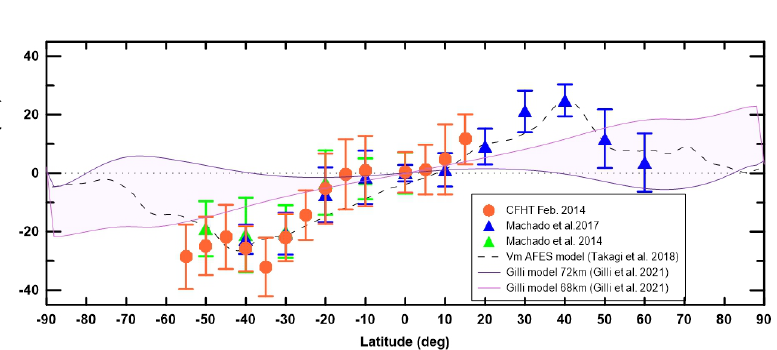
Figure 12. Comparison between a model’s predicted meridional flow latitudinal velocity profile and the profiles retrieved from ground-based observations and Doppler velocimetry techniques applied to the high-resolution spectra obtained with ESPaDONS/CFHT. The modelling profiles result from an average of five days; the observation-based profiles also consist of the mean profile from three to seven days of observations (depending on each observing run’ temporal length).